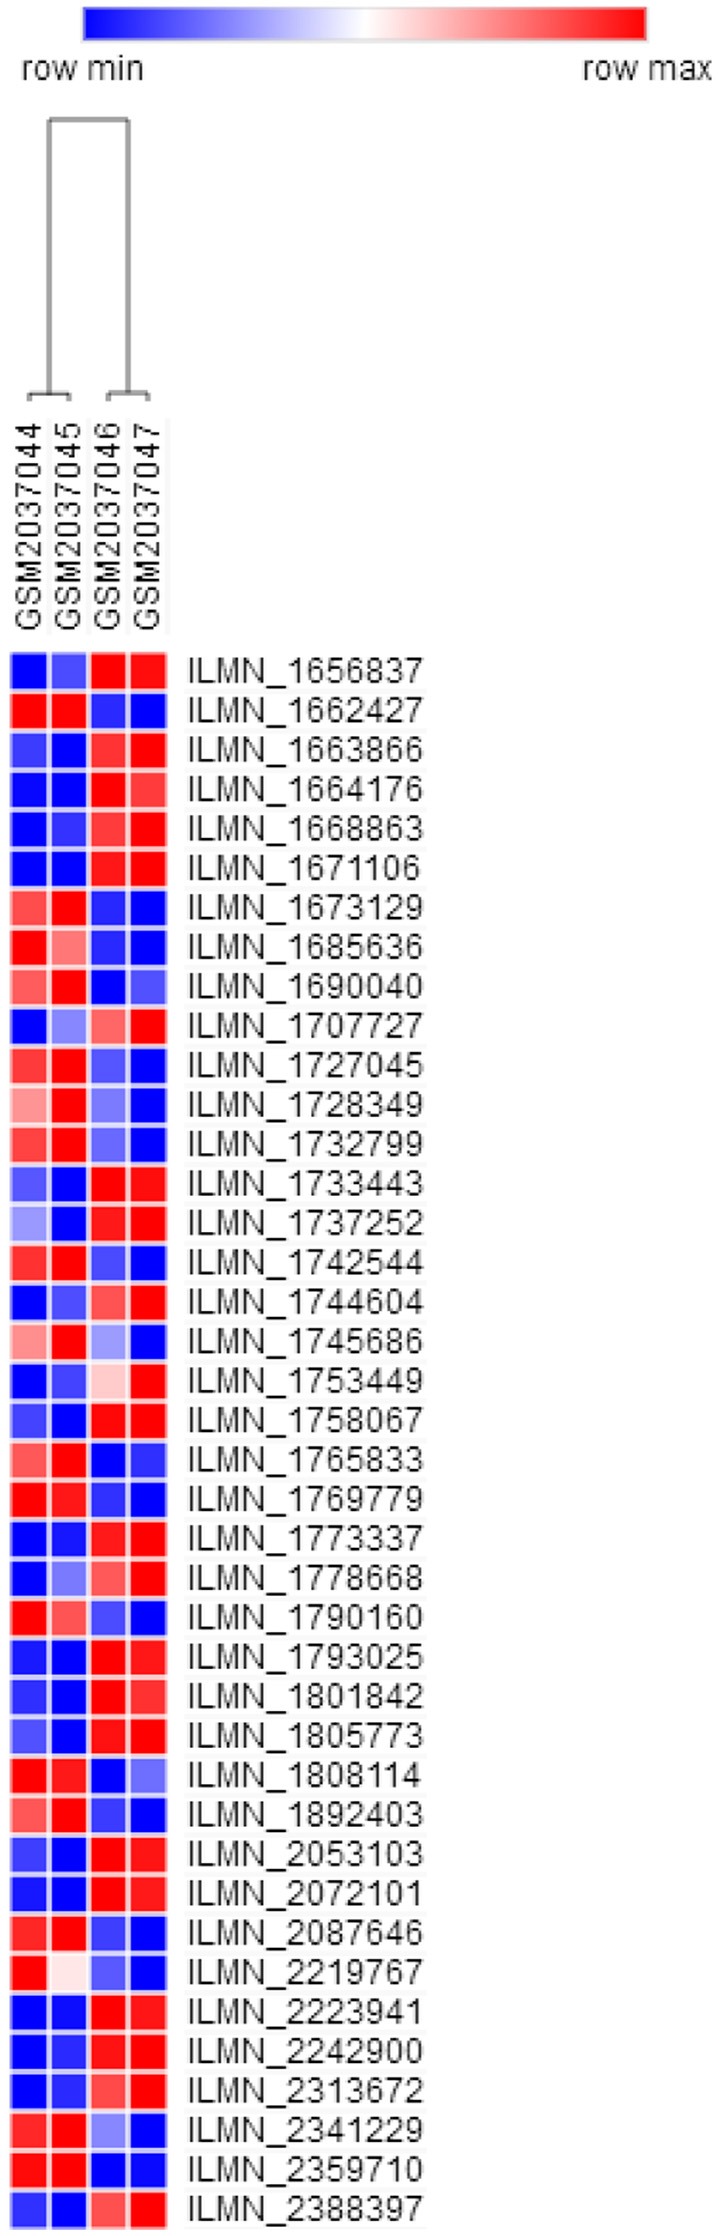
Heat map of DEGs (top 40 in fold change). Colors ranging from blue to red represent the DEGs' average fold change among the subjects. DEGs, Differentially expressed genes.